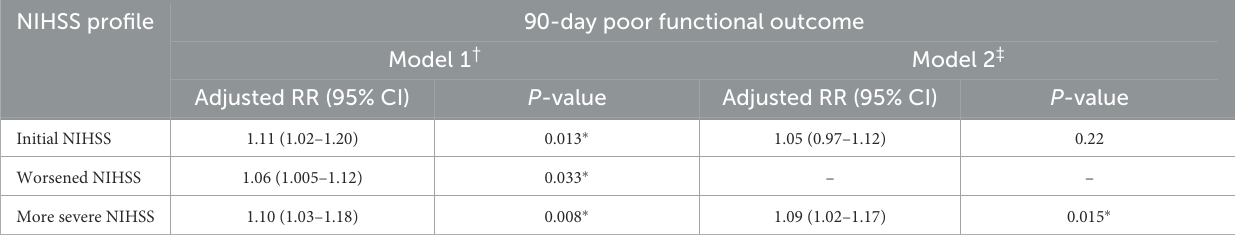
TABLE 5 Independent predictors of a 90-day poor functional outcome in patients with SSI-ND with PAD.